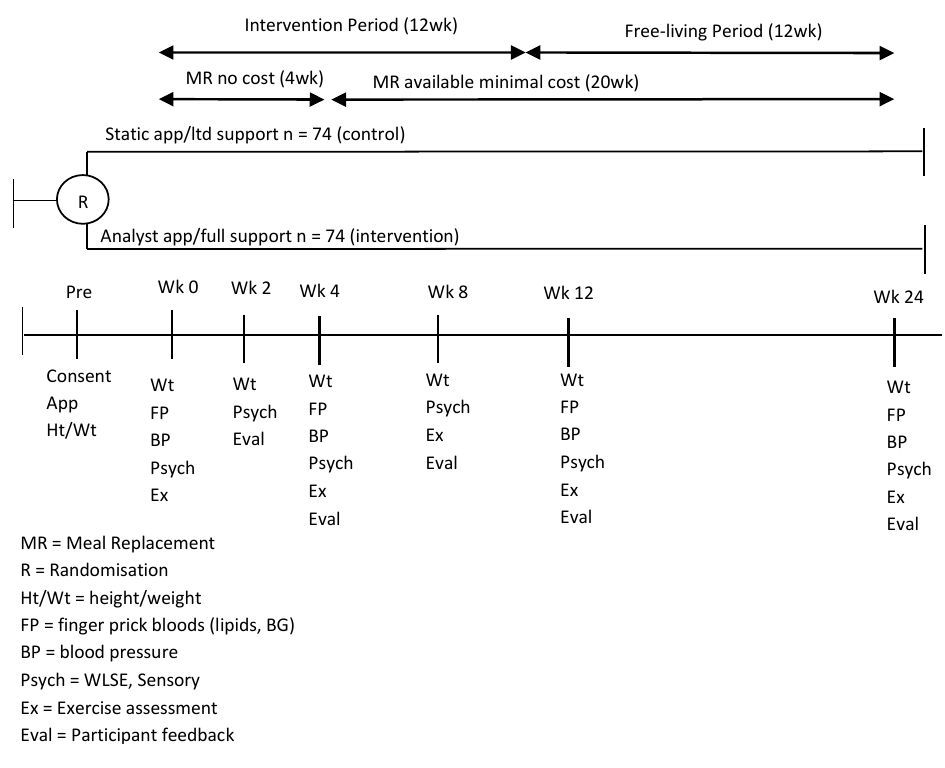
Figure 1. Study design over 24 ‐ weeeks.